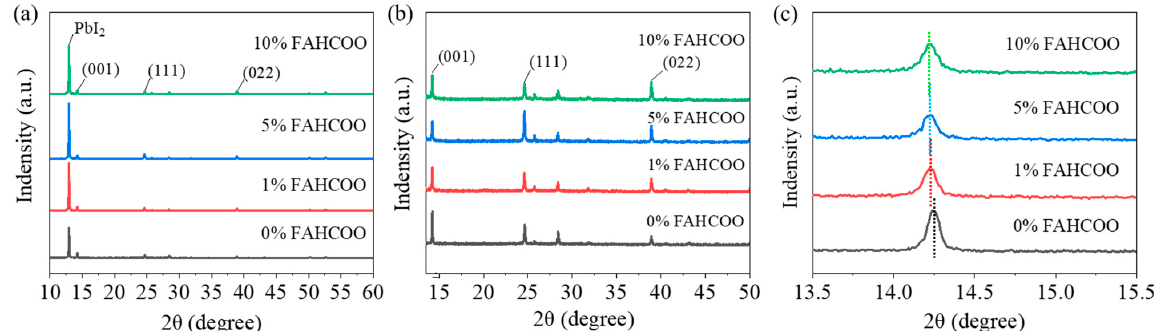
Figure 4. ( a ) XRD diffraction patterns of FAPbI 3 films with different concentration additions (0%, 1%, 5%, 10%) of FAHCOO. ( b ) The enlarged XRD diagram of α -FAPbI 3 film from Figure 4a. ( c ) Enlarged image of diffraction peak of (001) crystal plane from Figure 4a.